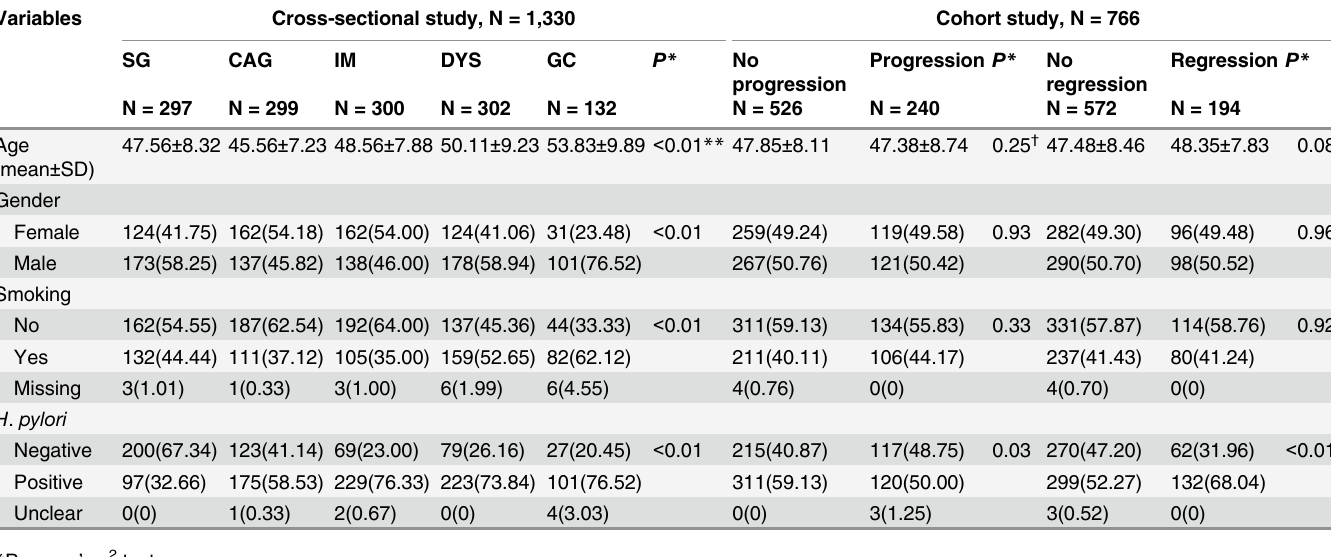
Table 1. Selected characteristics and risk factors in the study subjects, (n,